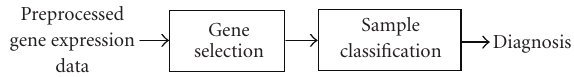
Figure 1: The pipeline of cancer diagnosis using gene expression